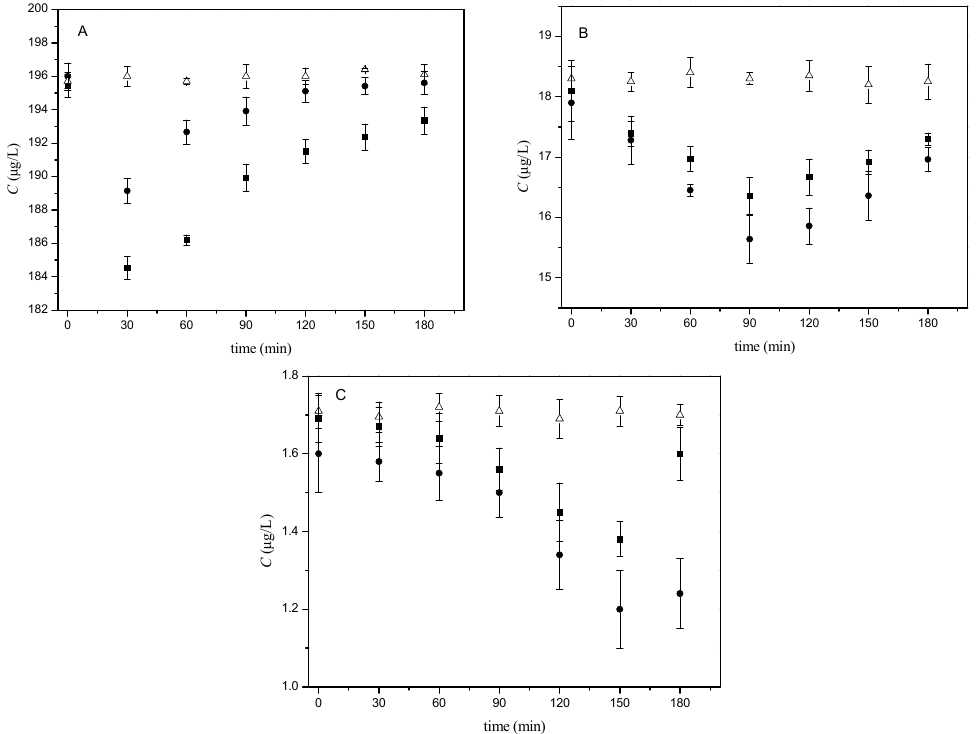
Figure 1. Dependencies of the concentration of total unbound estradiol on the time of mouse sperm capacitation in vitro. The tested concentrations of estradiol in M2 medium were ( A ) 200 µ g/L, ( B ) 20 µ g/L, and ( C ) 2 µ g/L. Each experiment was carried out for samples with added mouse sperm (solid circles for BALB/c sperm, solid squares for C57BL/6Nvel sperm) and for reference samples without sperm (blanks, open triangles). The samples were prepared in three parallel sets, where each set represented sperm collecting from one individual; each sample was measured in five replicates; experimental conditions: 50/50 ( v / v ) acetonitrile (ACN)/H 2 O, both containing 0.1% HCOOH, measured in multiple reaction monitoring (MRM) mode for transition 255.2 to 158.9; error bars were calculated using the standard deviations ( n ′ = 3). For details, see Sections 4.2 and 4.3 and Table A1 in Appendix B (Supplementary Materials).